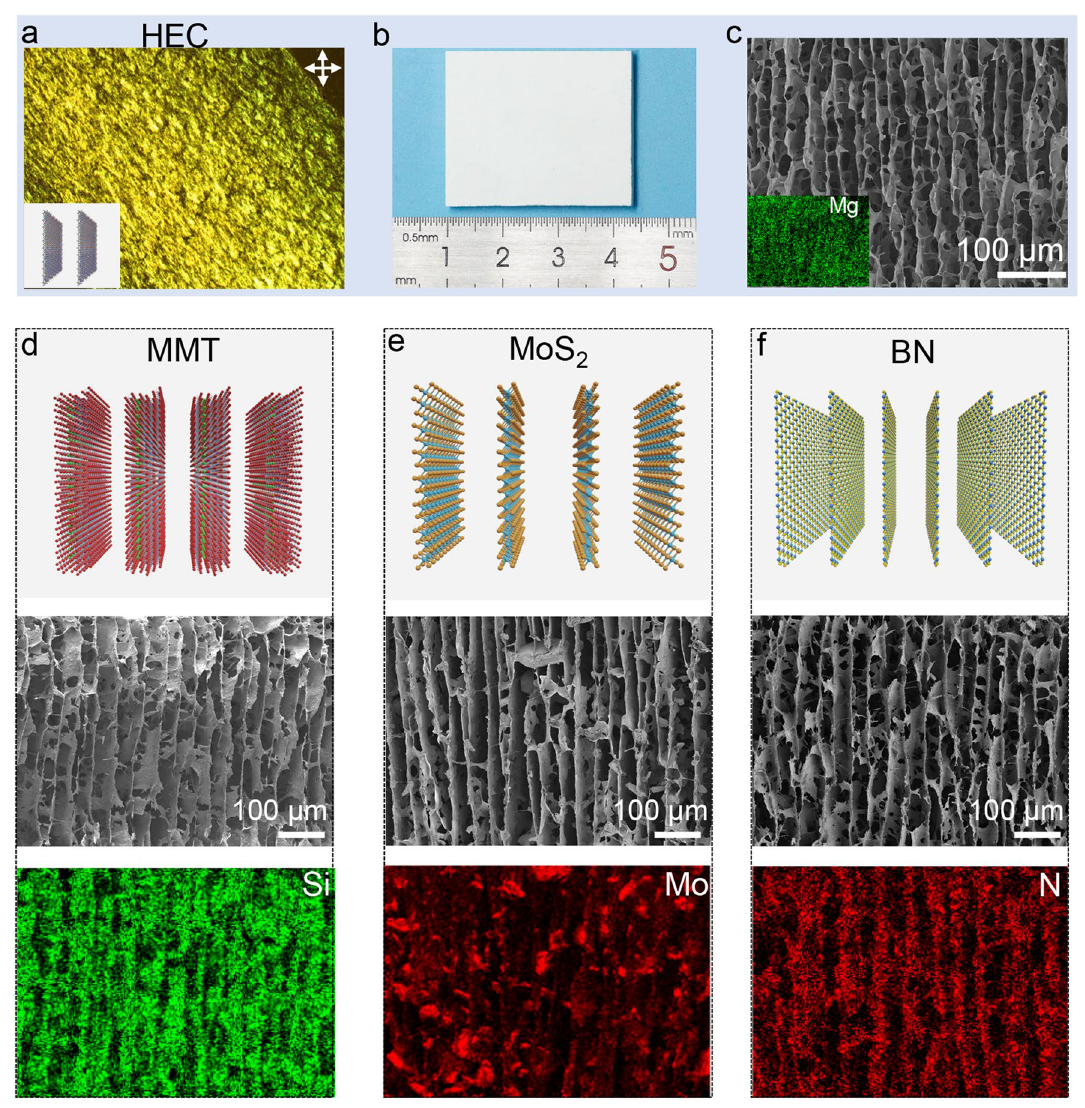
Fig. 4 a MDLCs of sodium hectorite (HEC). b Macroscopic images of dried monodomain skeleton of HEC. c Cross-sectional SEM image. Insert is energy-dispersive spectrometer images. d‑f Schematics of monodomain structures, cross-sectional SEM and energy-dispersive spec- trometer images of montmorillonite (MMT), molybdenum disulfide (MoS 2 ), and boron nitride (BN),